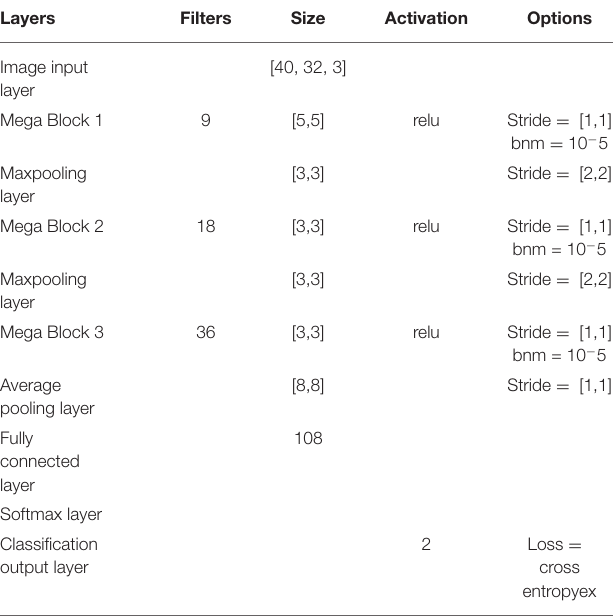
TABLE 3 | Number of convolutional layers for each subject used in Architecture-2 for inter-subject transfer learning purpose (MB = Maga Block).